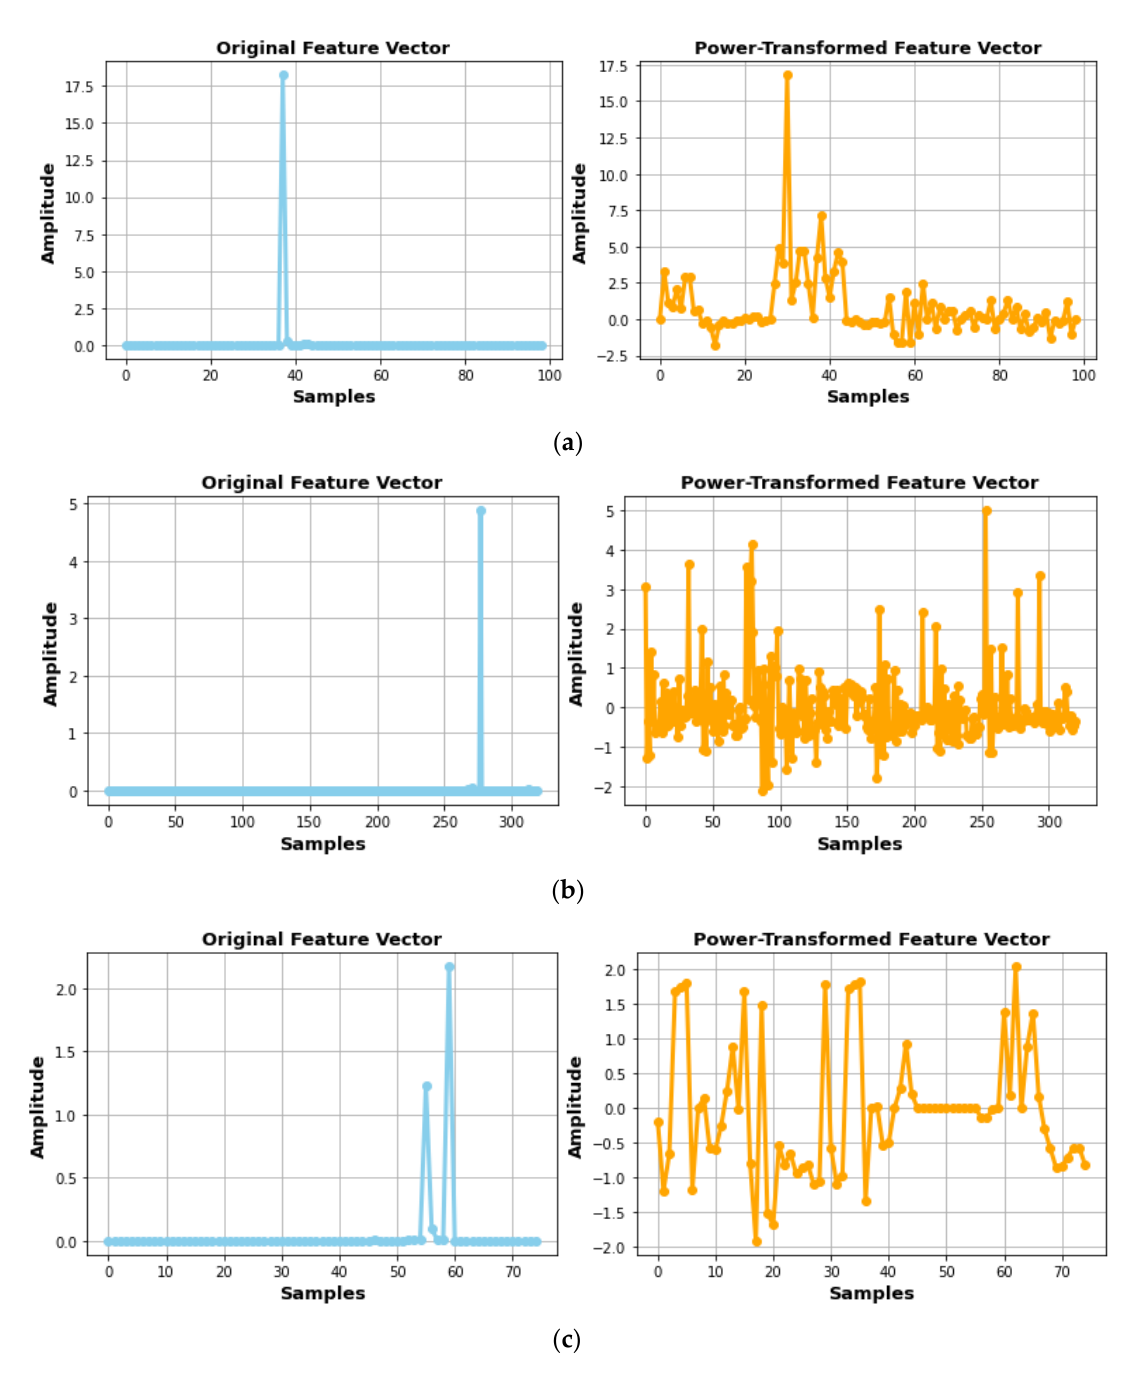
Figure 7. Original vs. power-transformed feature vector. ( a ) MobiAct_v2.0 original vs. power-transformed feature vector, ( b ) Real-World HAR original vs. power-transformed feature vector, and ( c ) Real-Life HAR original vs. power-transformed feature vector.